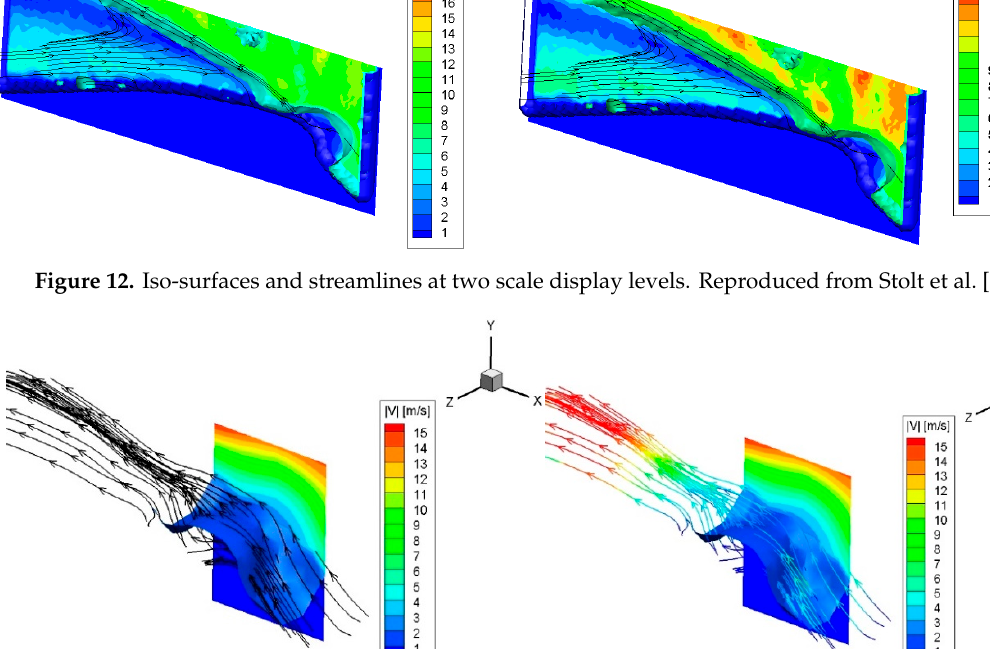
Figure 12. Iso-surfaces and streamlines at two scale display levels. Reproduced from Stolt et al. [30].